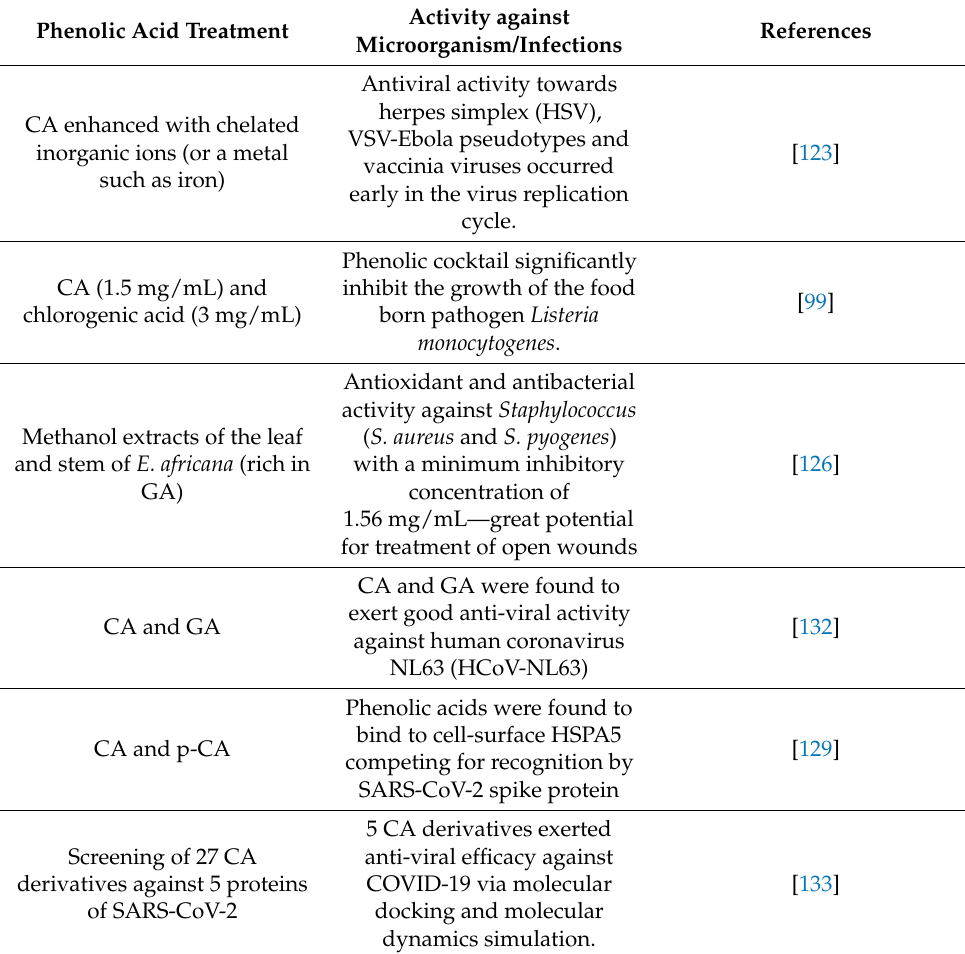
Table 2. Overview of the most recent studies on the potential activity of phenolic acids against microbial and viral relevant infections, including SARS-CoV-2. Activity Phenolic Acid Treatment